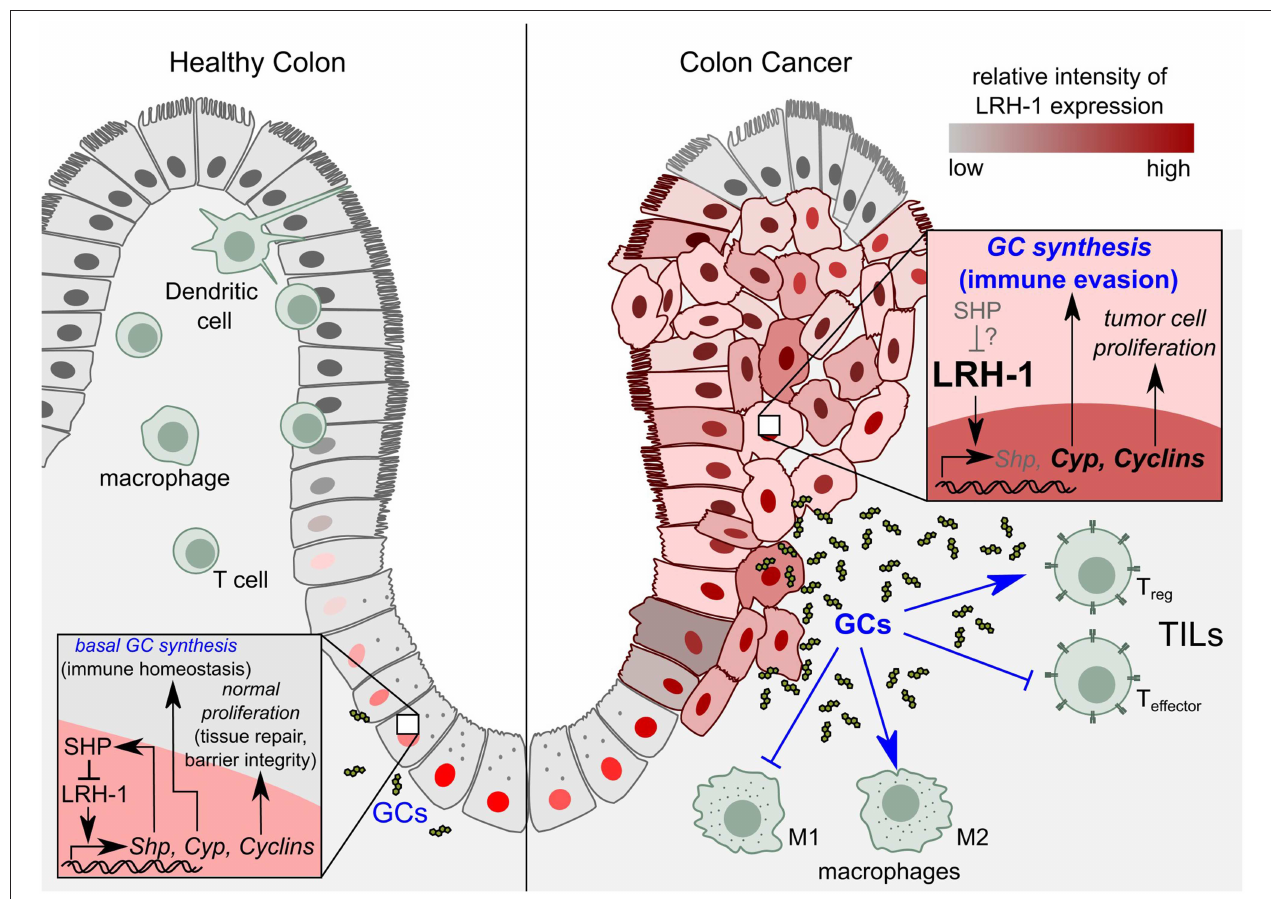
FIGURE 4 | Role of LRH-1 in healthy colon vs. colon cancer. Left panel: In healthy colon, LRH-1 is expressed in the nucleus of cells at the bottom of the intestinal crypts, where it regulates intestinal immune homeostasis by the regulation of cell proliferation through cyclins on the one hand, and the synthesis of immunoregulatory glucocorticoids (GCs) on the other hand. Right panel: In colon cancer, LRH-1 exhibits a nuclear as well as cytoplasmic expression pattern. LRH-1 induces colon tumor cell proliferation by upregulating expression of cyclins. LRH-1 is proposed to play a role in tumor immune evasion by the synthesis of immunosuppressive GCs that leads to the inhibition of anti-tumor immune responses. While in healthy tissue SHP imposes a negative feedback loop to LRH-1 signaling, the role of SHP in the molecular events during colon cancer development remains to be elucidated. SHP, Small heterodimer partner; TILs, tumor infiltrating lymphocytes; T reg , regulatory T cells; T effector , effector T cells; M1, pro-inflammatory macrophages (anti-tumor); M2, anti-inflammatory (tumor promoting) macrophages.